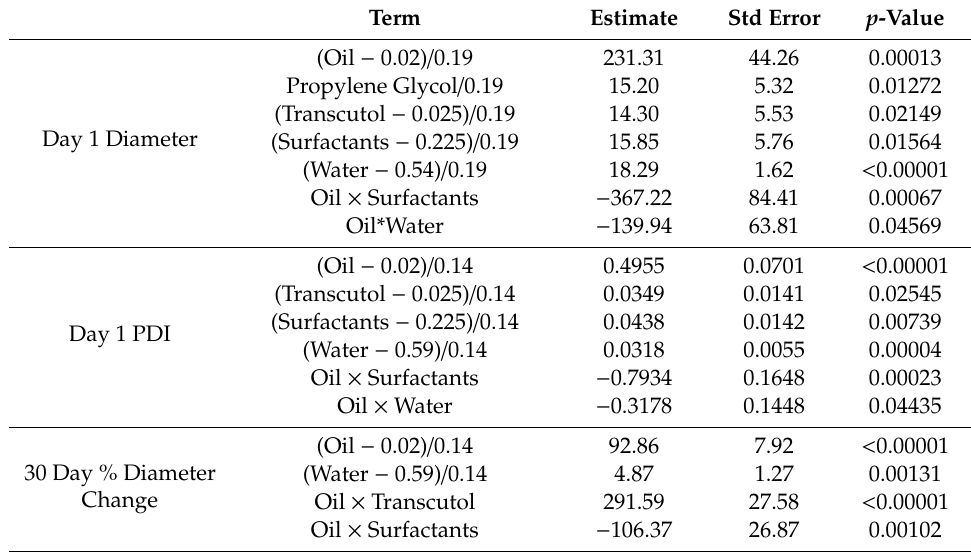
Table 9. Parameter estimates, standard errors, and p -values for the MLR models developed from the augmented design of